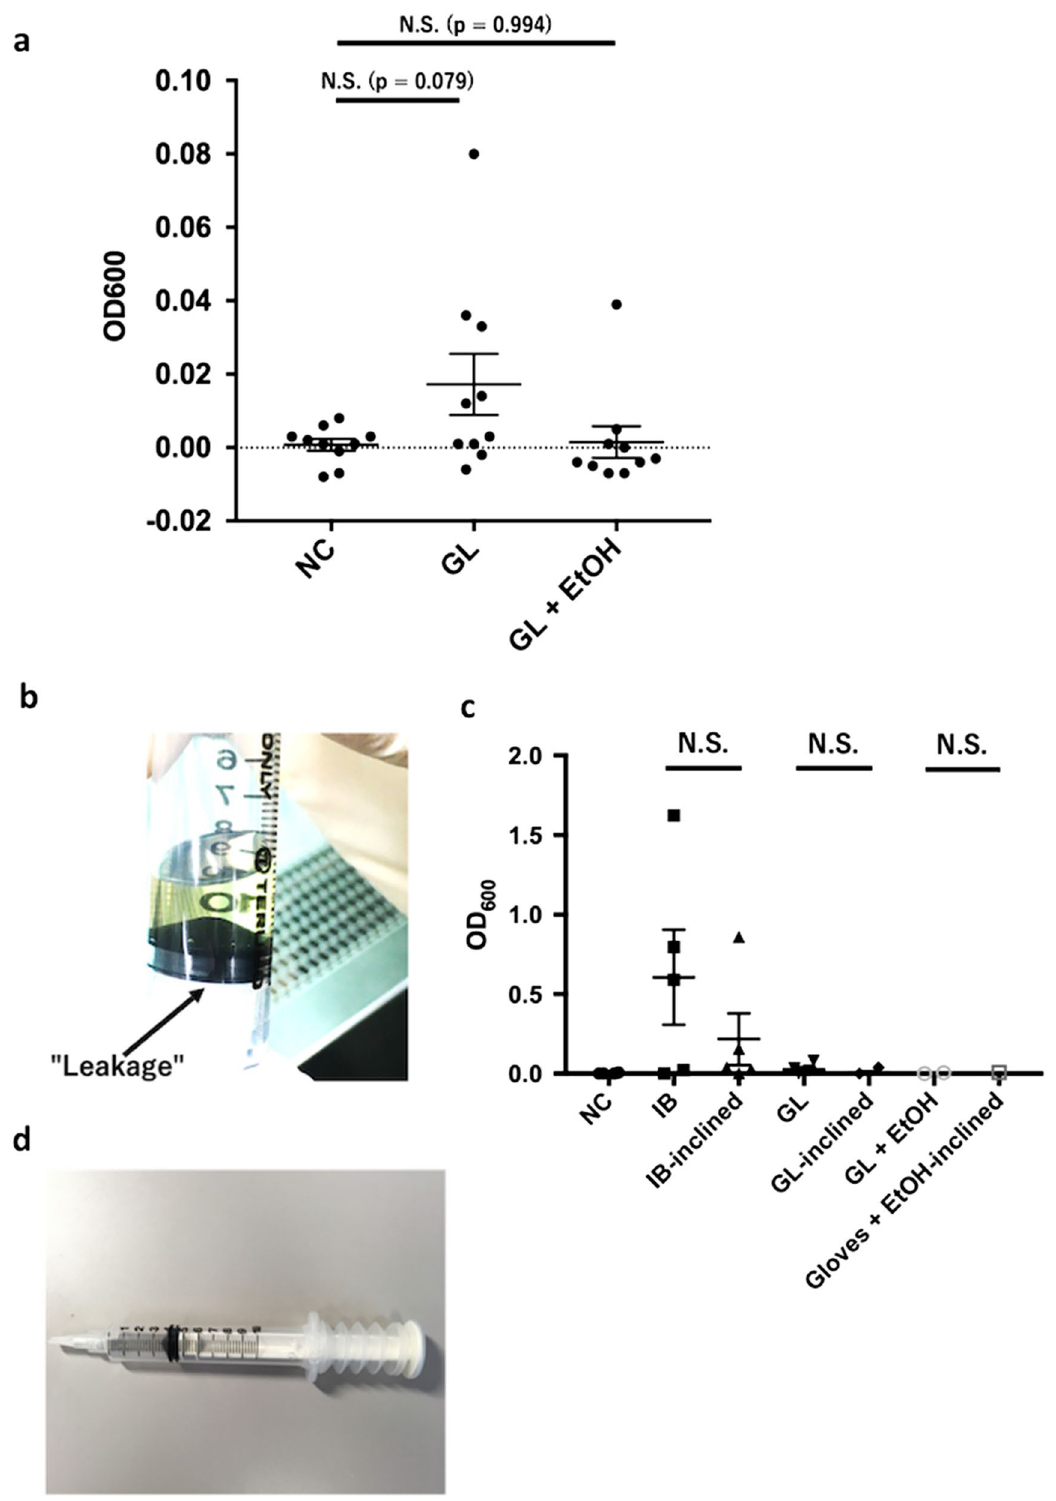
Figure 3. Disinfection with ethanol before PIS prevented PIS-induced contamination. ( a ) Comparison between NC, GL, and GL + EtOH conditions. Values are expressed as mean ± SEM, n = 10, ANOVA post-hoc Dunnett’s multiple comparison test. ( b , c ) Investigation on whether leakage of LB Miller medium through a lumen and a plunger induced intraluminal contamination. Values are expressed as a mean ± SEM, n = 5, Student’s t test. ( d ) Example of a commercially available plastic syringe with a plastic cover that prevents direct physical contact of the hand of the clinician with the plunger (Edwards Lifesciences, Irvine, CA,